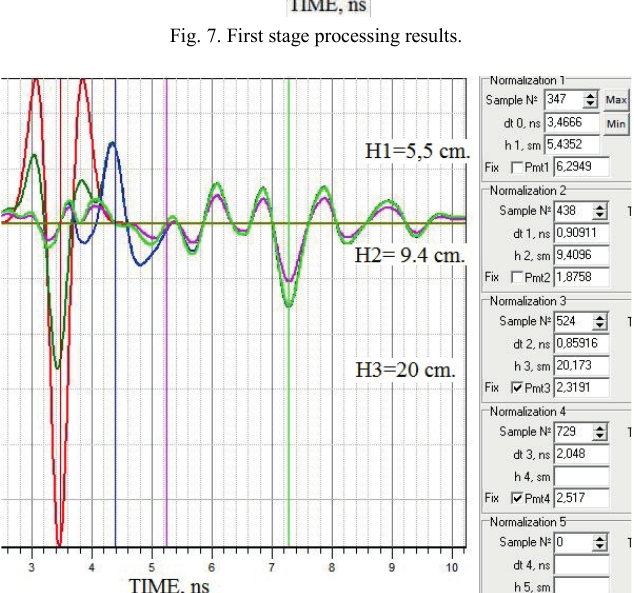
Fig. 8. Results of processing the data obtained in the laboratory using the Odyag-4.2